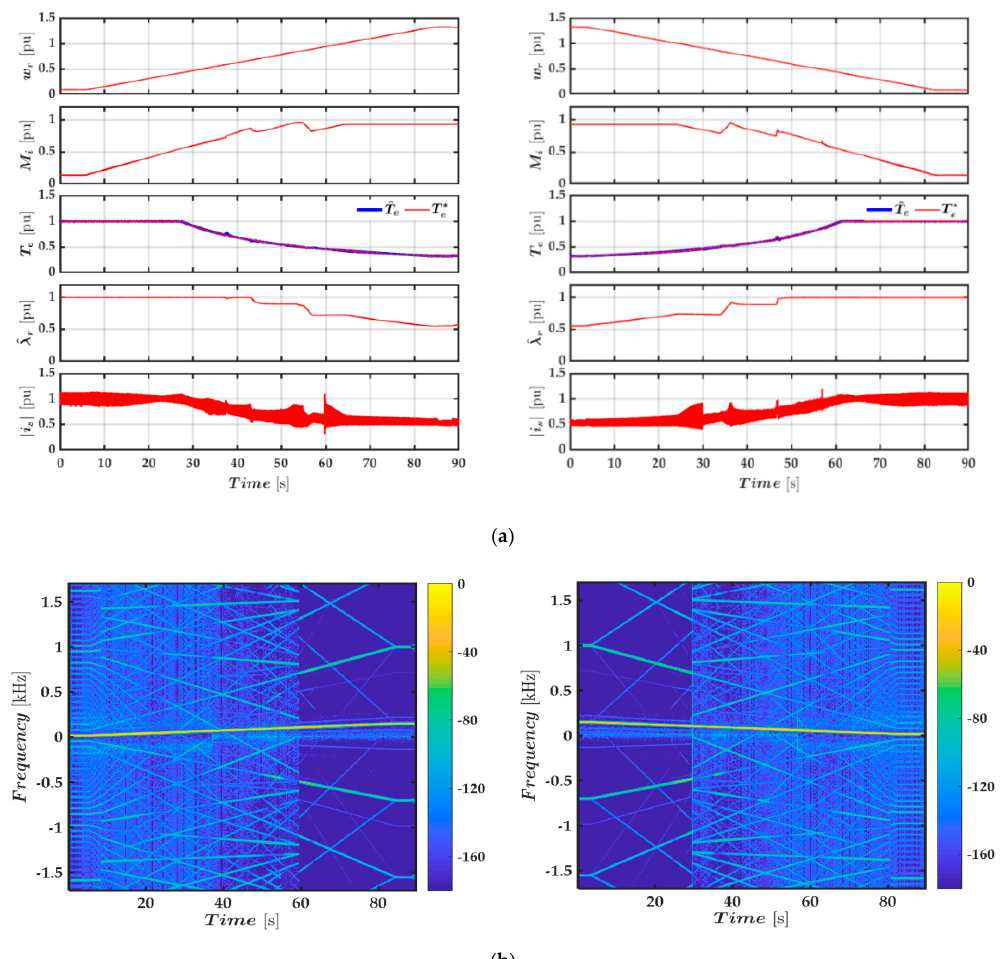
Figure 21. Experimental results. Acceleration (left)-deceleration (right) tests between 𝜔 (cid:3045) = 0.1 and 𝜔 (cid:3045) = 1.328 p.u. ( a ) From top to bottom: rotor speed, modulation index, commanded and estimated torques, estimated rotor flux, and magnitude of the stator current vector; ( b ) stator current vector spectrogram.